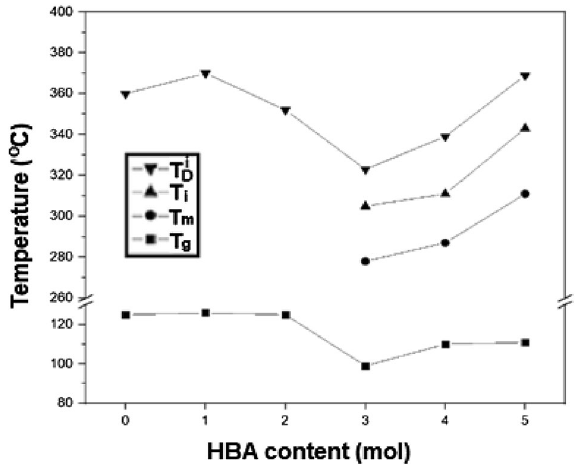
Figure 1. Thermal properties of Co-TLCPs with varying HBA content.